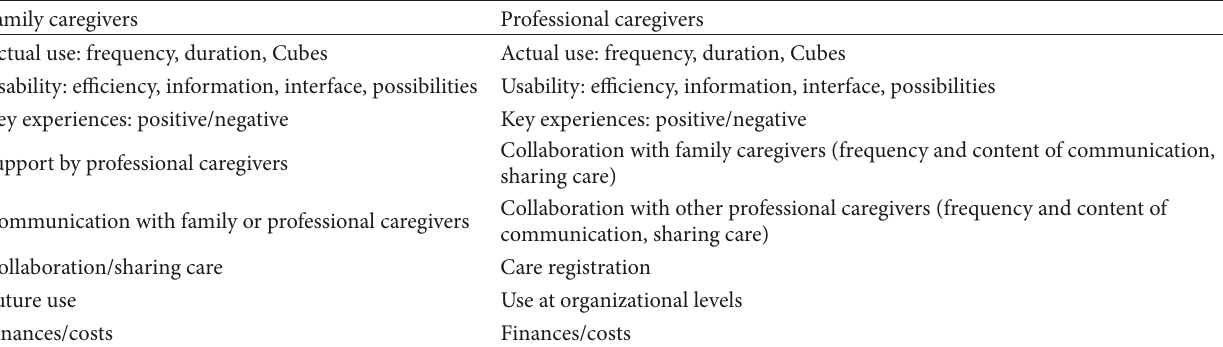
Table 1: Topic lists of interviews with caregivers.